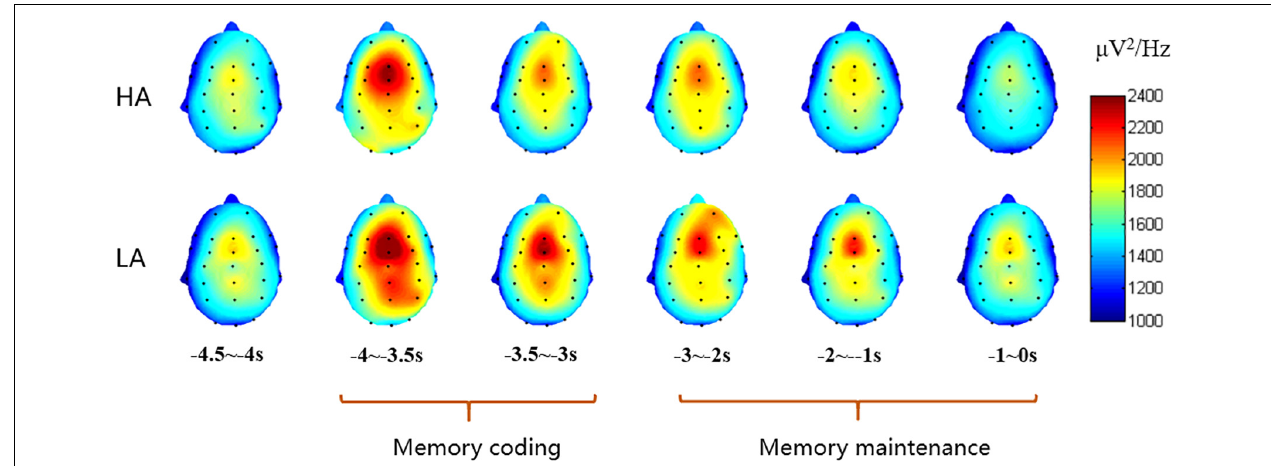
FIGURE 4 | 3-D plot of theta power for coding and delay periods of each group.